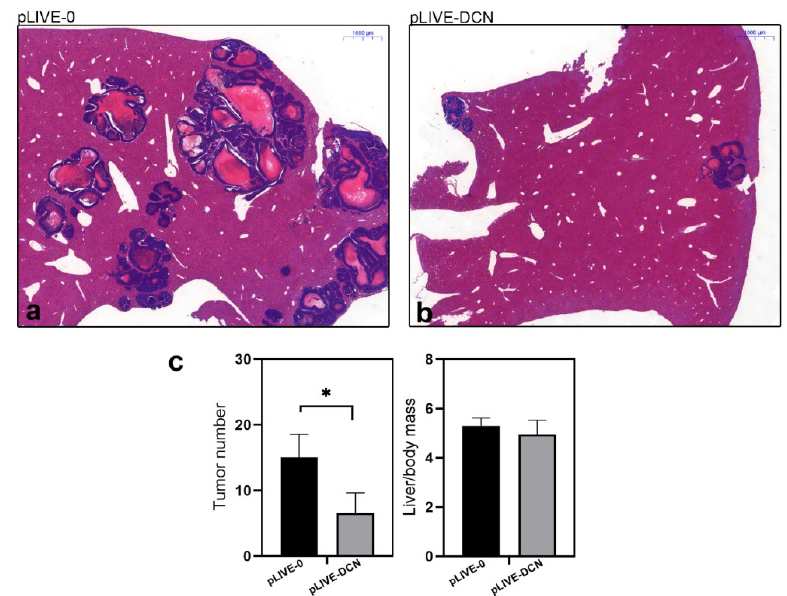
Figure 4. Representative histological images of hematoxylin and eosin-stained control (pLIVE-0) ( a ), and decorin expressing (pLIVE-DCN) ( b ) liver tissues after inoculation of c38 tumor cells. Bar charts ( c ) represent the ratios of tumor-bearing mice in experimental groups of control and DCN expressing groups. In livers overexpressing decorin, a reduced number of liver metastases was observed in parallel with lower liver mass/body ratio. Scale bar = 1000 μm. * p value < 0.05.